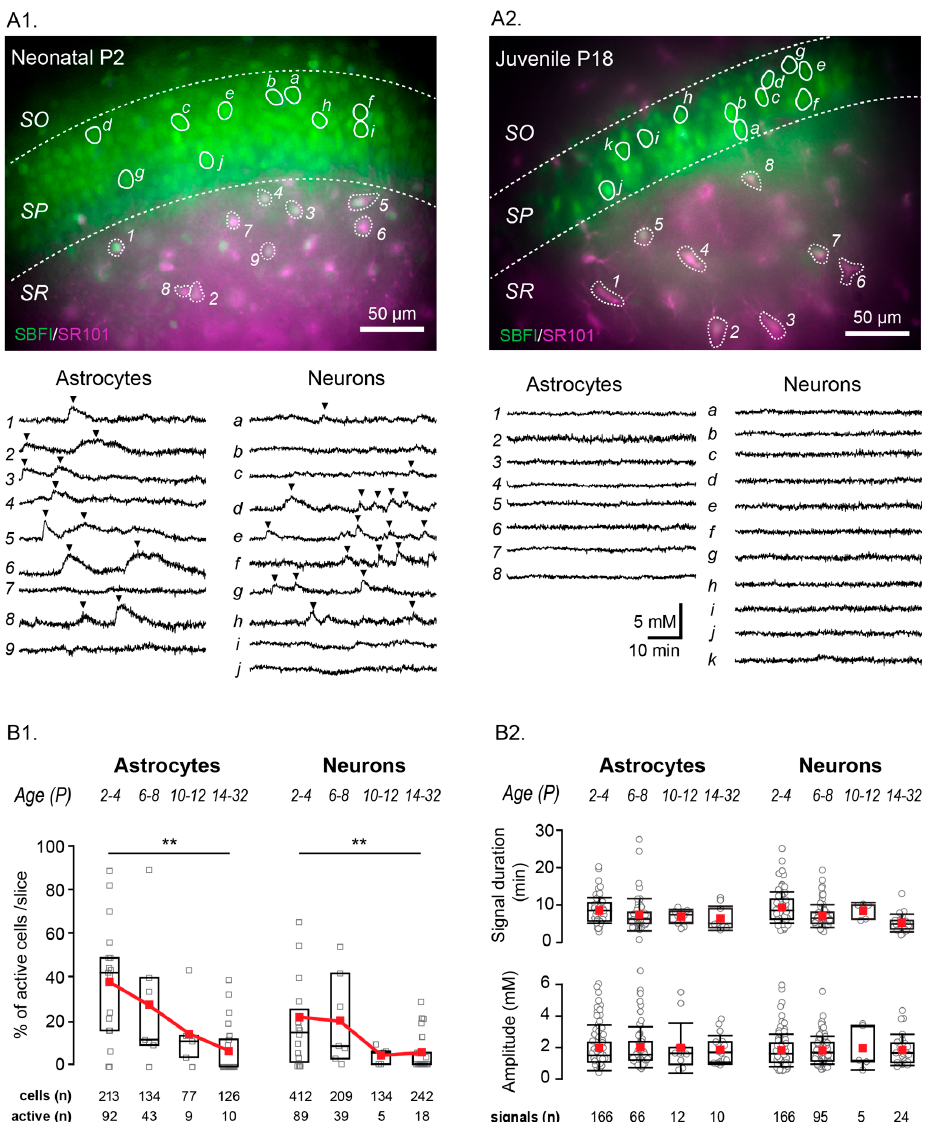
Figure 3. Age dependence of spontaneous Na + fluctuations. Example merged staining of a P2 ( A1 ) and P18 ( A2 ) hippocampal slice (SBFI in green, SR101 in magenta, overlapping regions in white) with example cells encircled and their individual fluorescent measurement traces shown below. Analyzed fluctuations are indicated by black arrows. Scale bars show 50 µm. SO, SP, SR: stratum oriens, pyramidale and radiatum, respectively. ( B1 ) Box plots illustrating the decline in percentage of cells showing activity per slice with increasing mouse age. ( B2 ) Properties from fluctuations in di ff erent age groups as written above. Box-and-whisker plots indicating median (line), mean (red square), interquartile range (box) and standard deviation (whiskers). ** 0.001 ≤ p <